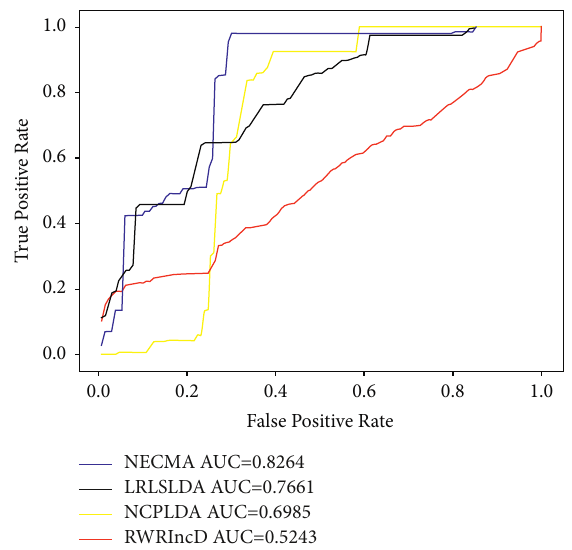
Figure 2: The AUROC values of the NECMA model and the other three algorithms on the ten-fold cross-validation.